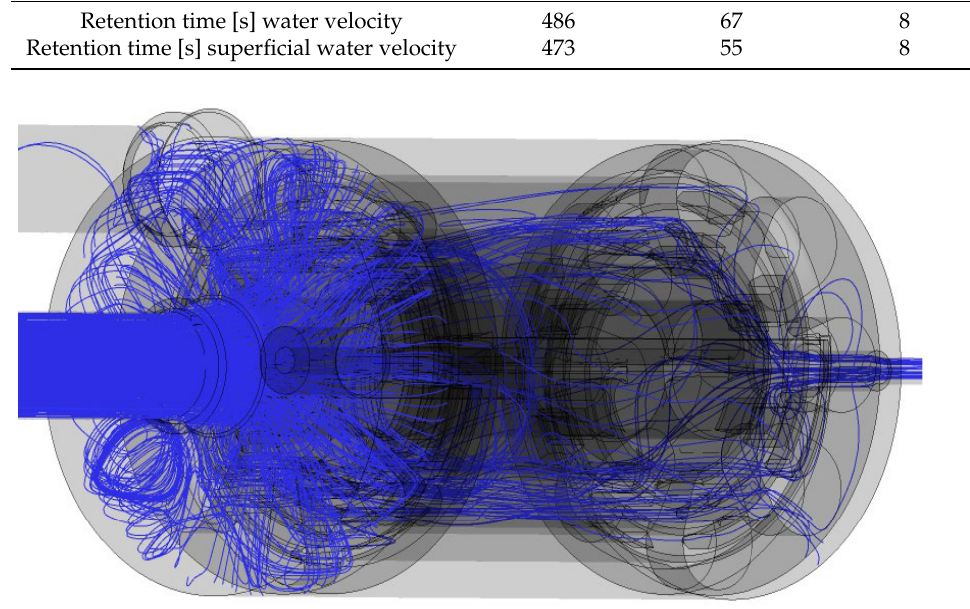
Figure 7. Water flow shown with streamlines during the watering period (left top, rotated 90°).